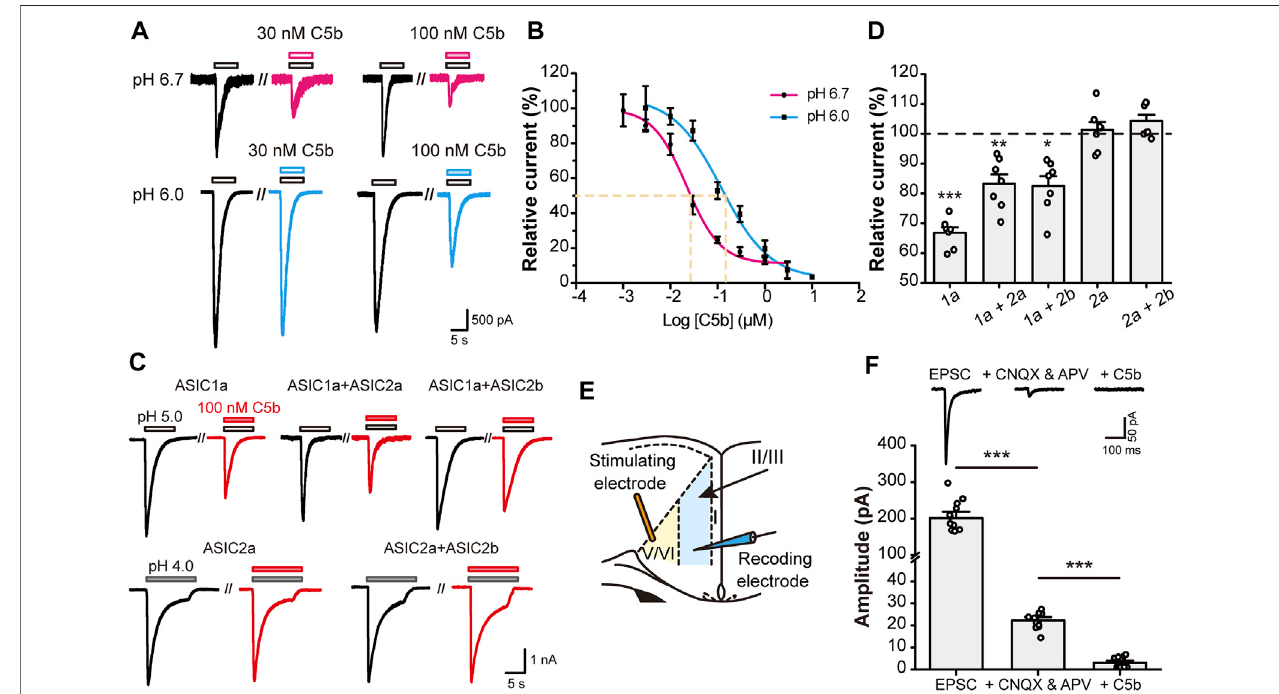
FIGURE1| C5bspeci fi callyinhibitedASIC1a-mediatedcurrents. (A) RepresentativetracesofC5binhibitionofASIC1acurrentsevokedatpH6.7(toprow)andpH 6.0 (bottom row) at indicated concentrations. CHO-K1 cells expressing mASIC1a were bathed in a pH 7.4 extracellular fl uid (ECF) before exposing to the pH 6.7 or pH 6.0 ECF. C5b was added with acidic stimulus as indicated. (B) pH dependence of C5b inhibition of ASIC1a. The acid-evoked currents were normalized to that in the absence of C5b. The data points ( n = 5 for each) were fi tted by the Hill equation, which yielded IC 50 of 22.2 nM for pH 6.7 and IC 50 of 121.9 nM for pH 6.0. (C) RepresentativetracesofpairedacidstimulationsofASICcurrentsintheabsence( black )andpresence( red )of100 nMC5b.CHO-K1cellswereco-transfectedwithGFP and the indicated plasmids and used for whole-cell patch-clamp recording 24 h later. GFP-positive cells were fi rst stimulated with the acidic ECF in the absence of C5b and then inthe presence of 100 nM C5b at 3 min after the washoutofthe originalacid-evoked current (I 0 ). (D) Peak currents in thepresence of100 nM C5b normalized to the peak I 0 for conditions shown in (C) . n = 7 for each group. Statistical signi fi cance for each group was determined by one sample t test compared with the hypothetical value of 100% for no inhibition. * p < 0.05, ** p < 0.01, *** p < 0.001. (E) Schematic diagram of electrophysiological stimulation and recording of EPSCs in anterior cingulate cortex (ACC) in mouse brain slice. (F) C5b sensitivity of EPSCs of ACC pyramidal neurons. EPSCs were recorded as in (E) in the absence of any drug ( left )orinthepresenceof20 μ MCNQXand50 μ MAPVtoblocktheglutamate-dependentpostsynapticcurrents( middle )or20 μ MCNQX,50 μ MAPV,and100